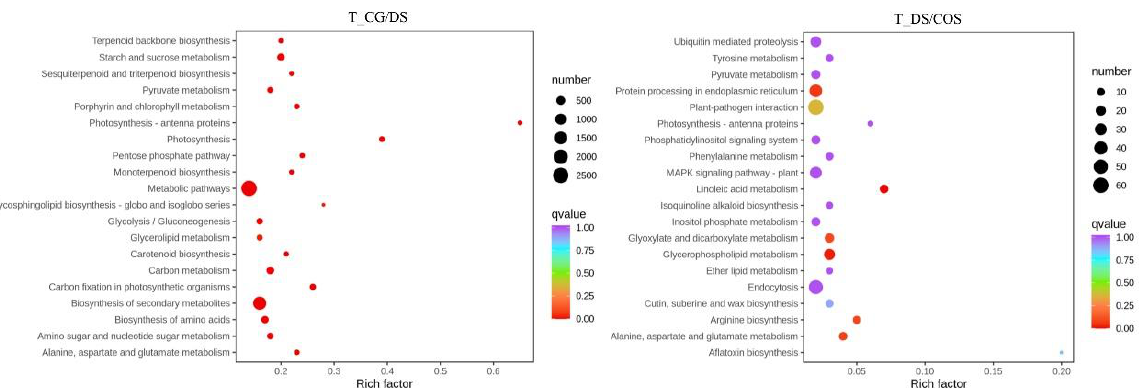
Figure 3. Top-20 KEGG pathway enrichment of DEGs in the DS and COS treatment groups compared to the control group (CG/DS; left panel) and to each other (DS/COS; right panel). The size of the circles corresponds to the number of DEGs and are color-coded according to q-value. The x-axis shows the enrichment factor value.